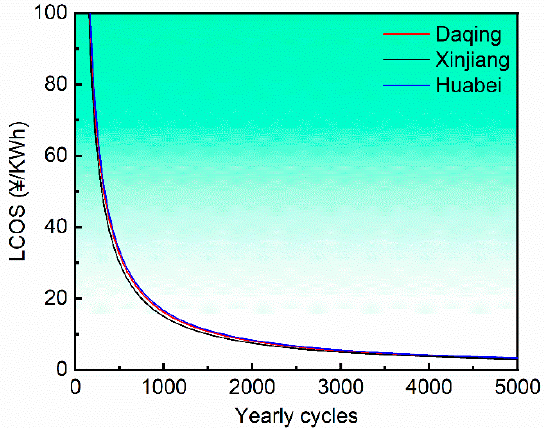
Figure 6. Variation of the LCOS with the annual cycle times of the gravity energy storage system by virtue of the abandoned wells in the three major oilfields.